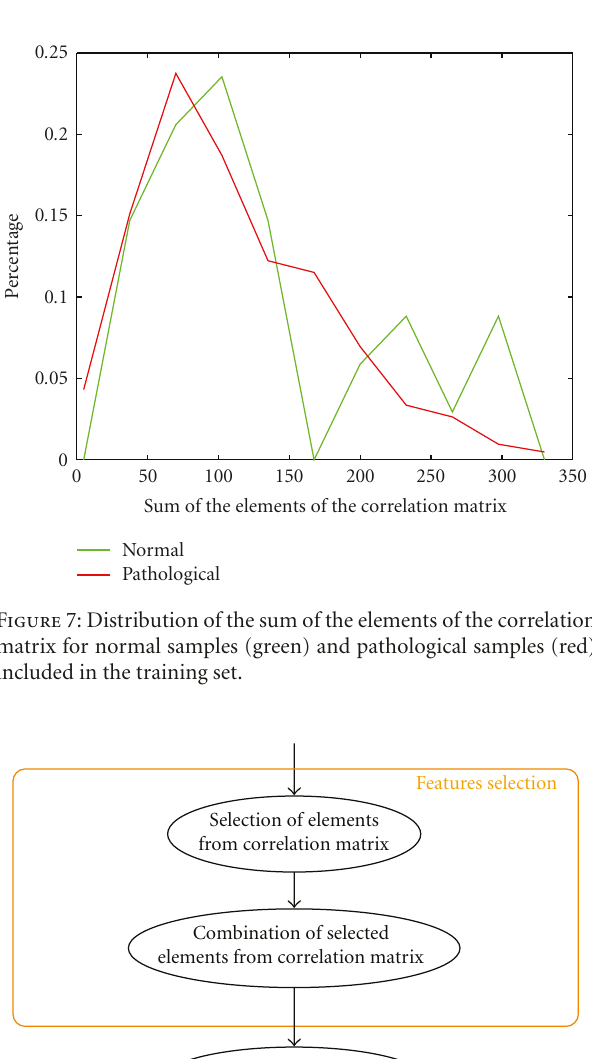
computed for all samples of the training set and, to assess the classification performance of this factor, the correlation matrix has also been computed for the samples in the test